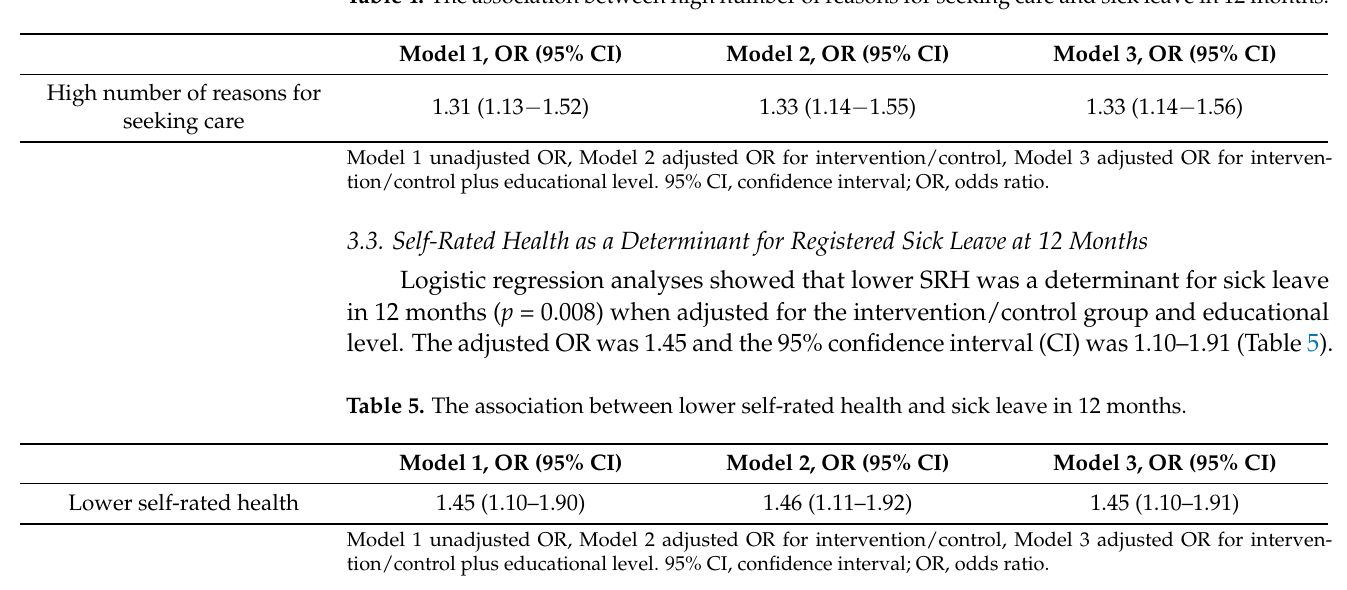
Table 4. The association between high number of reasons for seeking care and sick leave in 12 months.